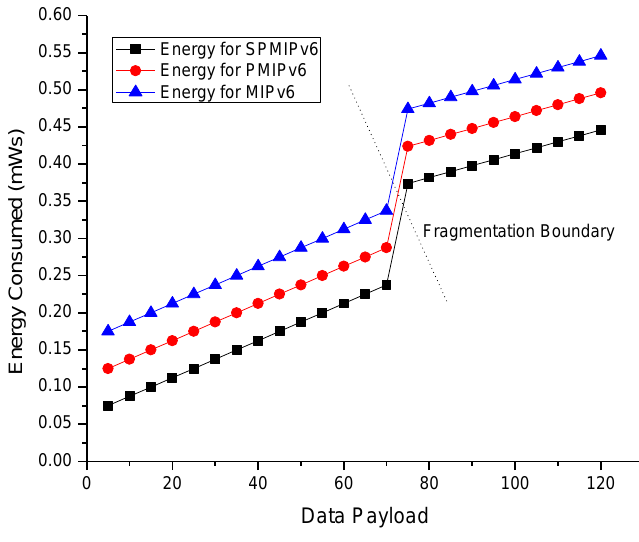
Figure 13. Data payload vs. Energy